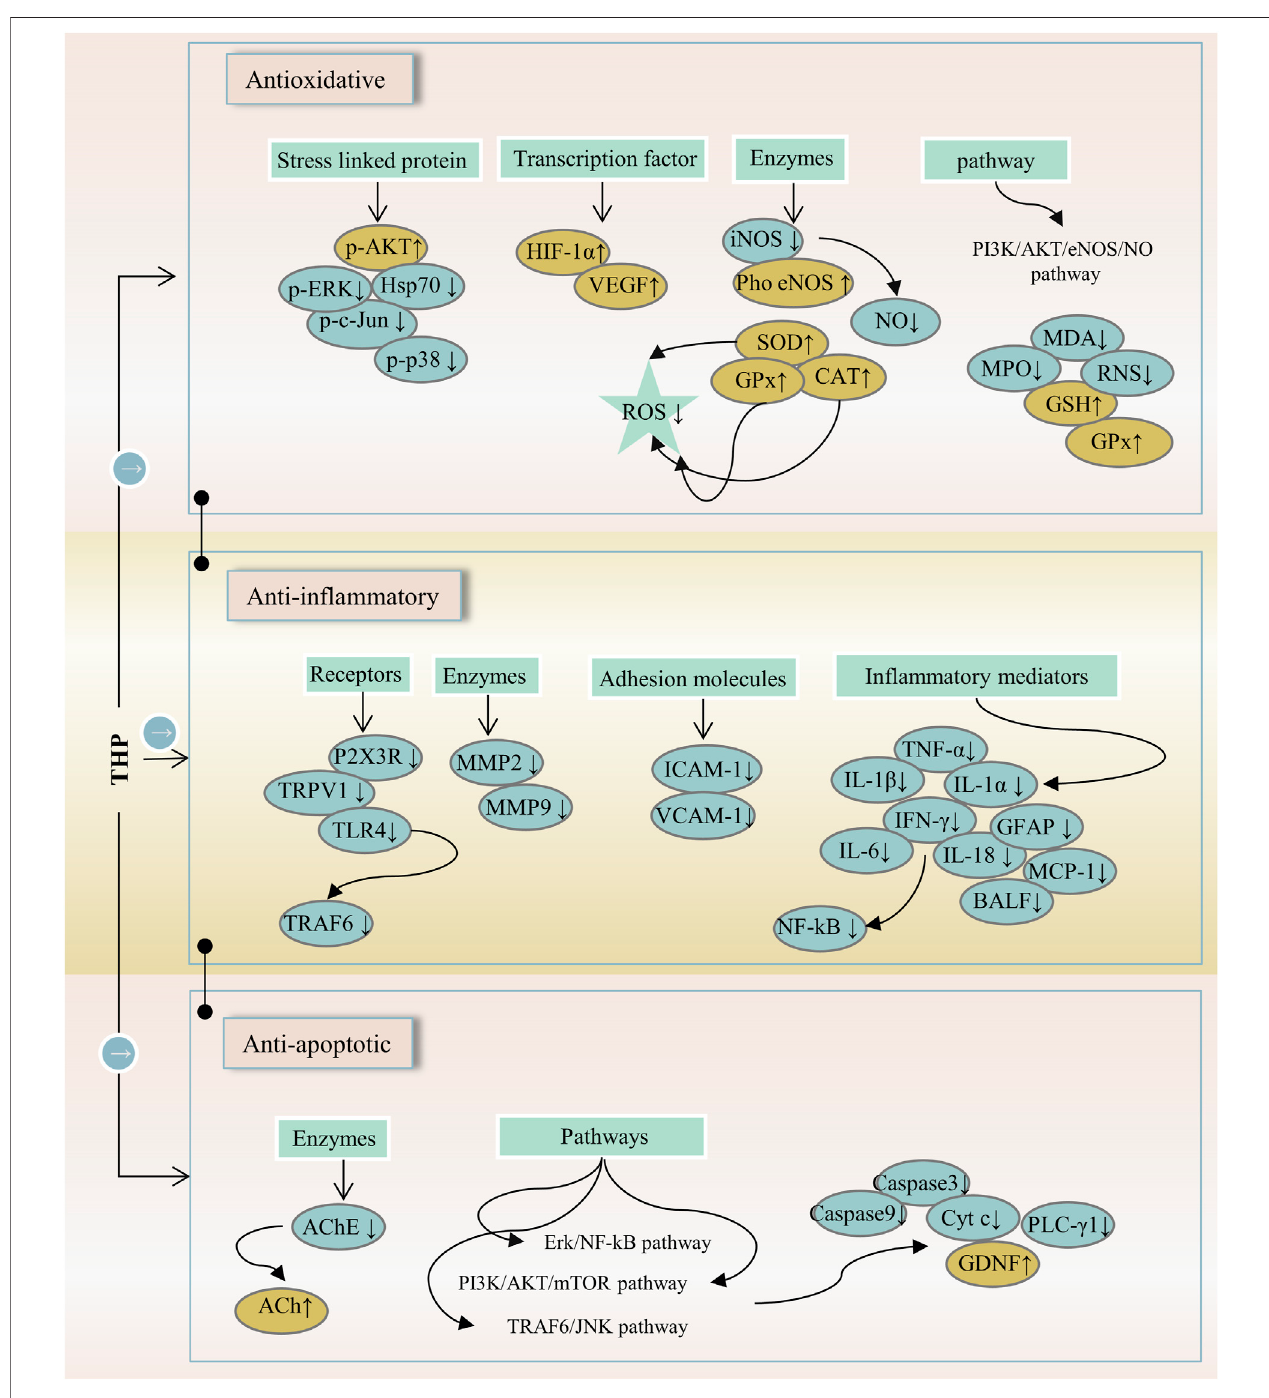
FIGURE 4 | The main targets and pathways of anti-in fl ammatory activity of THP. Abbreviations: p-AKT, Phosphorylated AKT; p-ERK, Phosphorylated extracellular signal- regulated kinase; Hsp70, 70-kDa heat shock protein; p-c-Jun, Phosphorylated c-Jun; p-p38, Phosphorylated p38; HIF-1 α , Hypoxia-inducible factor 1-alpha; VEGF, Vascular endothelial growth factor; iNOS, Inducible NO synthase; Pho eNOS, Phosphorylated endothelial nitric oxide synthase; NO, Nitric oxide; SOD, Superoxide dismutase; GPx, Glutathione peroxidase; CAT, Catalase; ROS, Reactive oxygen species; PI3K/AKT/eNOS/NO, Phosphatidylinositol 3-kinase/AKT/endothelial nitric oxide synthase/nitric oxide;MDA,Malondialdehyde;MPO,Myeloperoxidase;RNS,Reactivenitrogenspecies;GSH,Glutathione;P2X3R,P2Xpurinergicionchanneltype3receptor;TRPV1,Transient receptorpotentialvanilloid1;TLR4,Toll-likereceptor4;TRAF6,TNF-receptorassociatedfactor-6;MMP2,Matrixmetalloproteinase-2;MMP9,Matrixmetalloproteinase-9;ICAM- 1, Intercellular adhesion molecule-1; VCAM-1, Vascular cell adhesion molecule-1; TNF- α , Tumornecrosis factor alpha; IL-1 β , Interleukin-1 beta; IL-1 α , Interleukin-1 alpha; IFN- γ , Interferon-gamma; GFAP, Glial fi brillary acidicprotein; IL-6, Interleukin-6; IL-18,Interleukin-18; MCP-1, Monocytechemoattractantprotein-1; BALF, Bronchoalveolar lavage fl uid; NF- κ B, Nuclear factor-kappa B; AChE, Acetylcholinesterase; ACh, Acetylcholine; Erk/NF- κ B, Extracellular signal-regulated kinase/nuclear factor-kappa B; PI3K/AKT/mTOR, Phosphatidylinositol 3-kinase/Akt/mechanistic target of rapamycin; TRAF6/JNK, TNF-receptor associated factor-6/c-Jun N-terminal kinase; Cyt c, Cytochrome c; PLC- γ 1, Phospholipase C gamma 1; GDNF, Glial cell-derived neurotrophic factor.